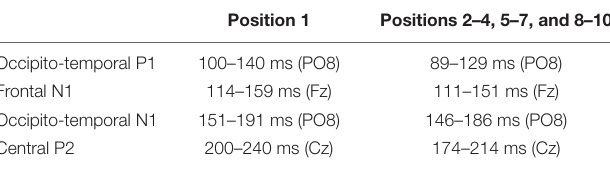
TABLE 2 | Time windows for calculating mean amplitudes of VEPs in Experiment